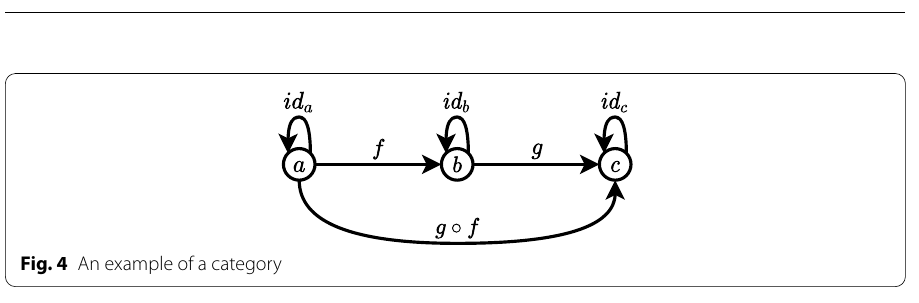
Fig. 4 An example of a